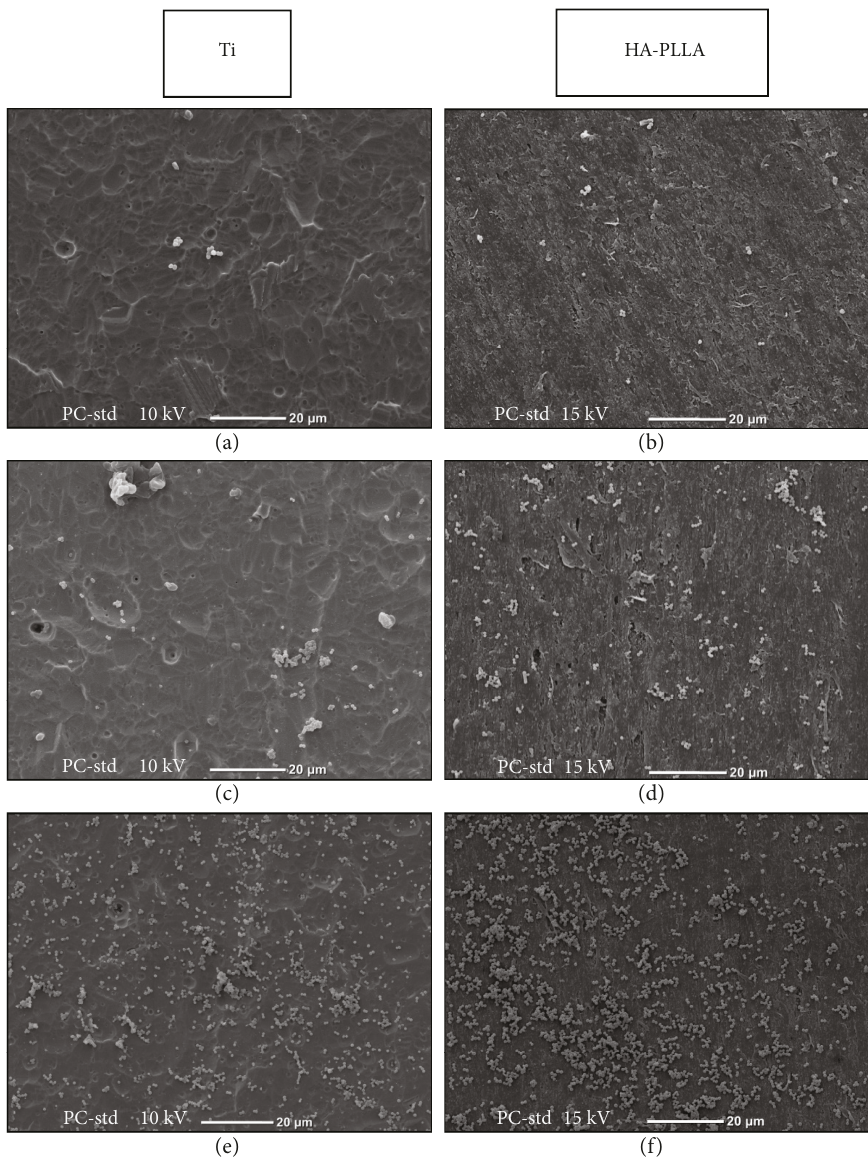
Figure 2: Bacterial adhesion of on the surface of Ti (a, c, e) and HA-PLLA (b, d, f) at 3 h (a, b), 24 h (c, d), and 48 h (e, f) after the inoculation of bacterial suspension. SEM images show that more and larger bacterial colonies were formed with the passage of incubation time. No obvious di ff erences were noted in the bacterial adhesion between the two